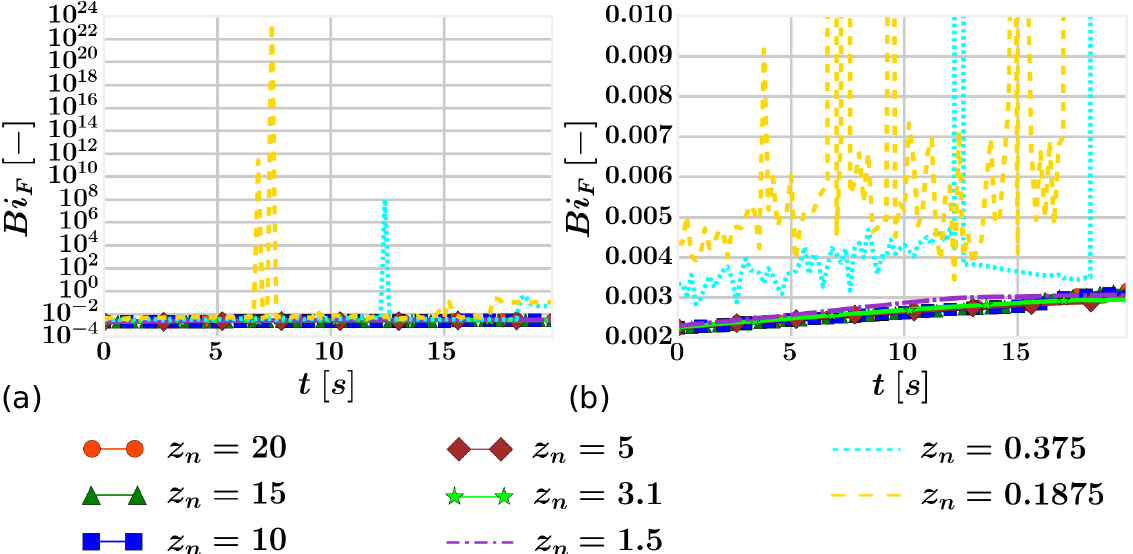
Figure 10. Fluid Biot number according to Equation (38) at location L 3 using various fluid meshes and with IPC activated. ( a ) Global view ( b ) Focused view on z n ≥ 1.5 mm.